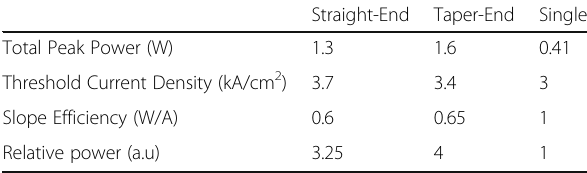
Table 1 Output Characteristic of the Three Different Devices Straight-End Taper-End